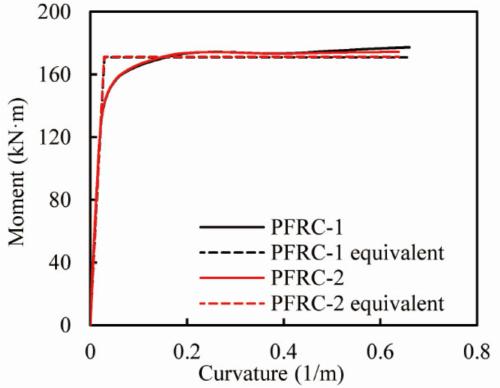
Figure 16. Equivalent yielding moment and curvature at column